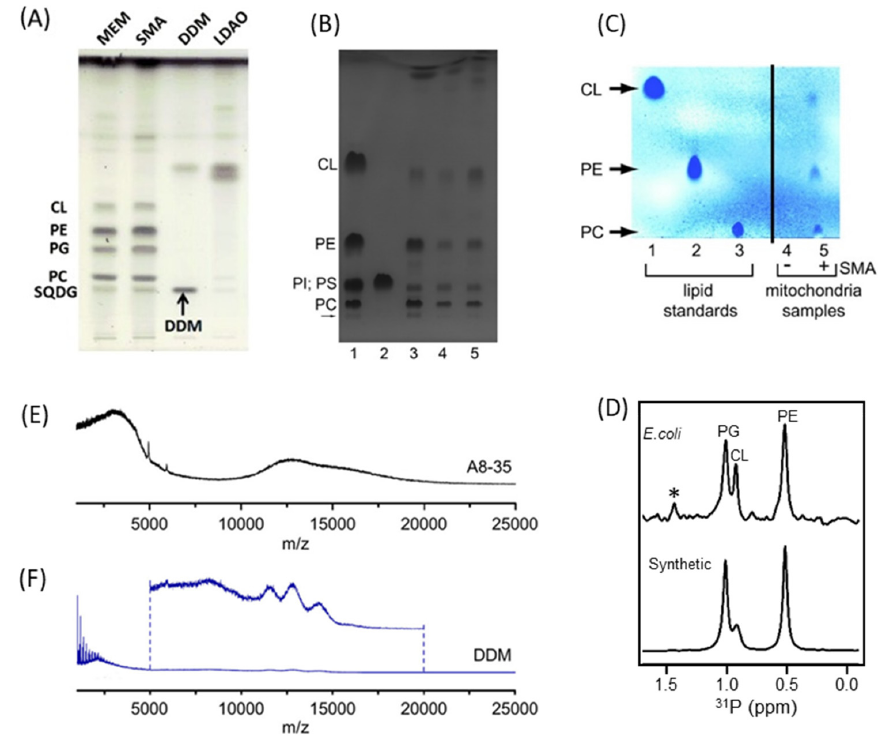
Figure 7. Analysis of phospholipids in the local lipid polymer-nanodiscs. ( A ) TLC of lipids present in membranes and nanodiscs was identified by running pure synthetic samples of each as a standard (not shown). Bands above the labeled lipids are attributed to photoreaction center ([RC] from the